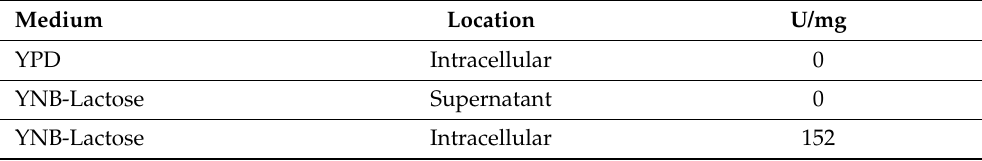
Table 1. Localization and specific activity of ATCC 20509 β -galactosidase on different media. Medium